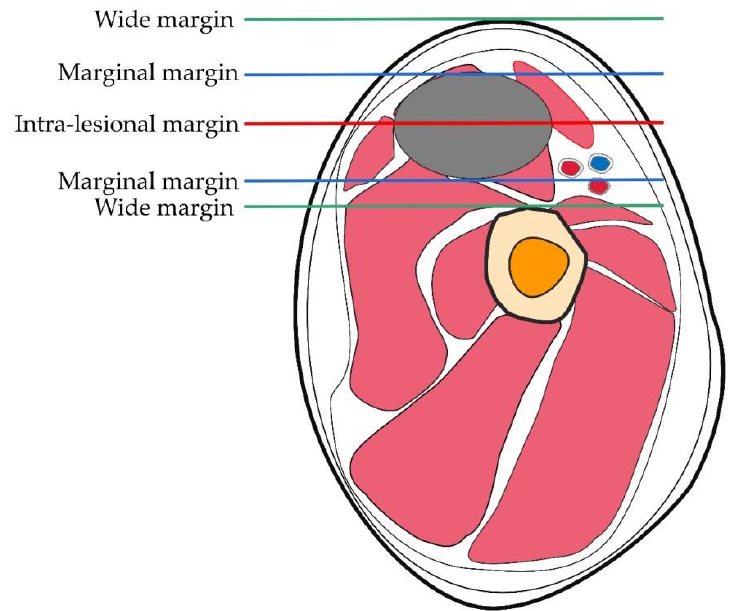
Figure 1. MSTS system for OS surgical resection margins. An intra‑lesional margin is formed when any point enters the tumor during OS resection. The red line represents the intra‑lesional margin. Margins are formed when peeling during surgery stretches to or across the reaction zone surround‑ ing the tumor. The blue line represents the marginal margin. Wide margins are created when there is no access to the reaction zone and the entire dissection passes through healthy tissue. The green line represents the wide margin. Table 1. Comparison of two classifications of surgical margins for OS [9]. Negative Predictive Preoperative Planning Classification Sensitivity Value Instructions